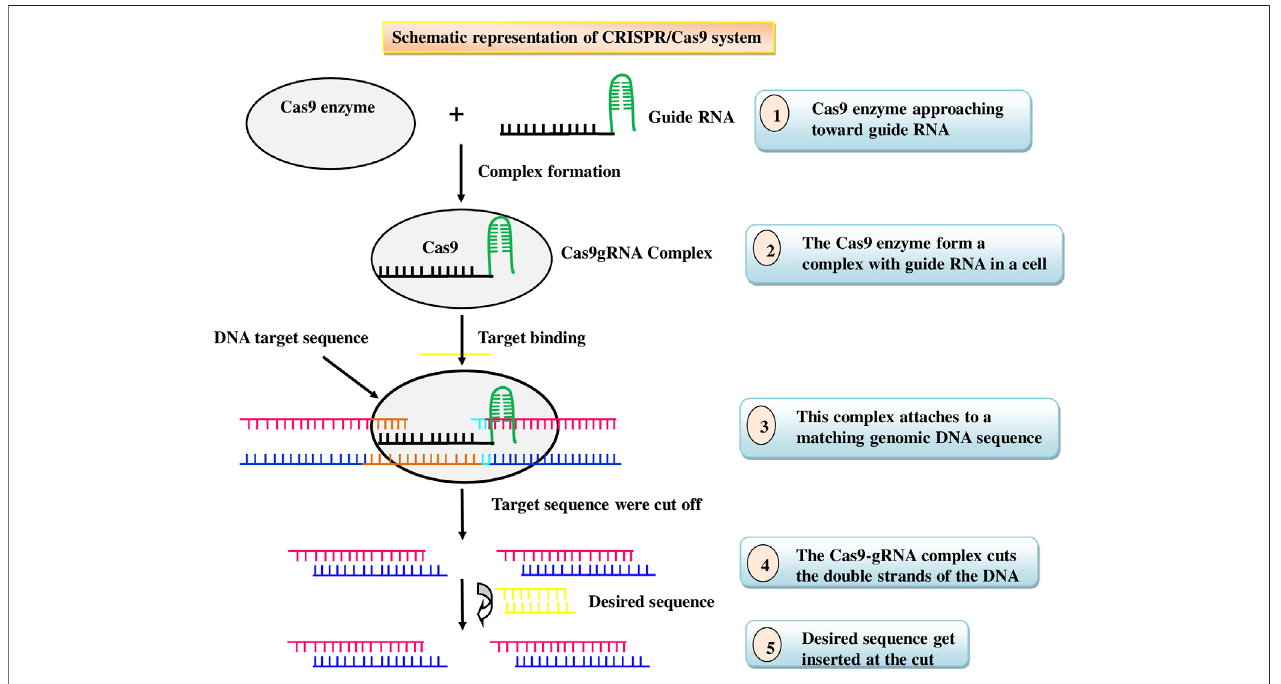
FIGURE 4 | Schematic representation of CRISPR/Cas9